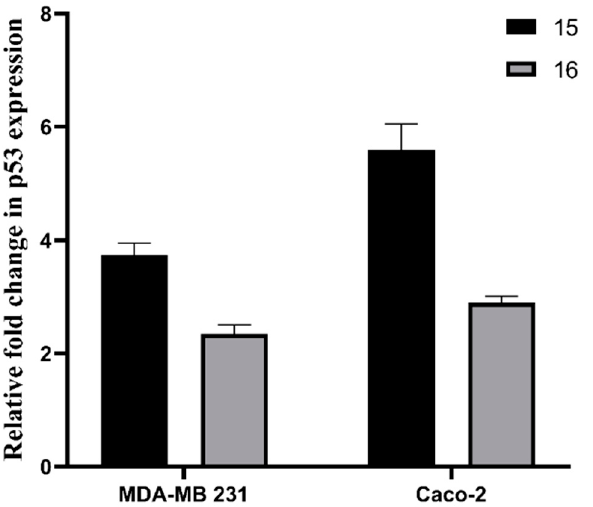
Figure 3. Relative fold change in p53 expression in MDA-MB 231 and Caco-2 cells after treatment with 15 and 16 at their respective IC 50 concentrations. All values are expressed as mean ± SEM.